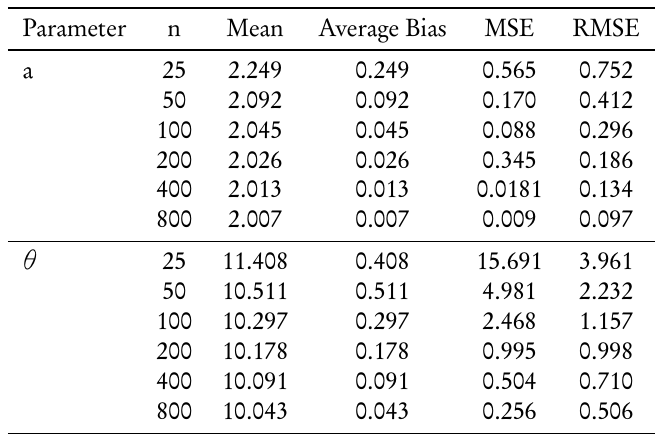
The simulation results for a = 2, θ = 10